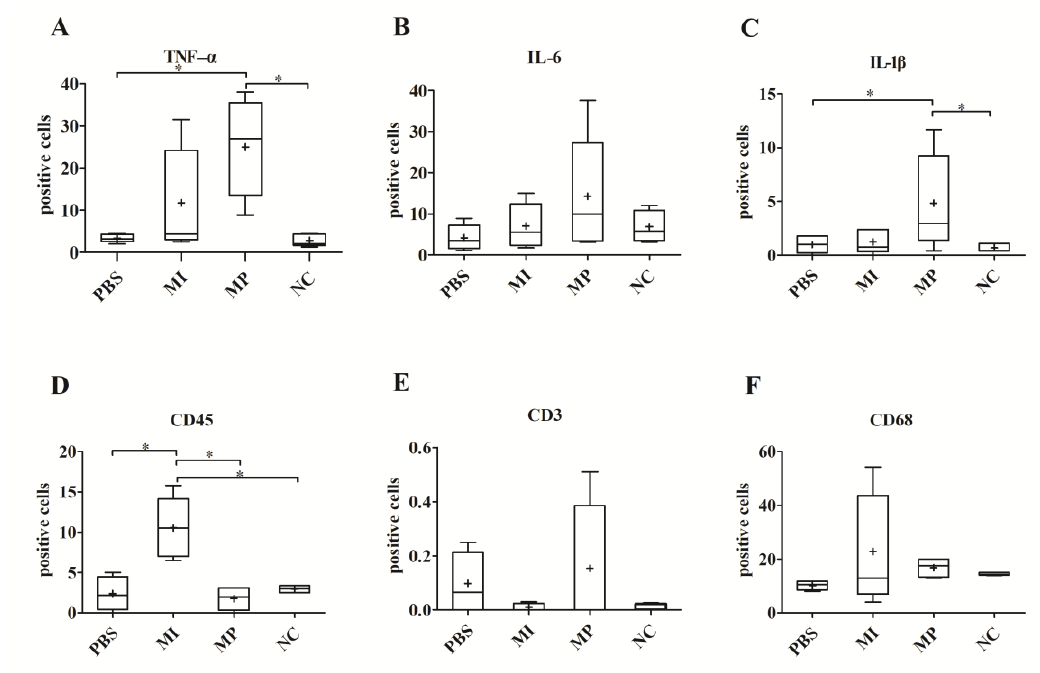
Figure 3. Expression of all biological markers in the synovial layer of right murine knees. The aim of examining the right knees was to evaluate systemic reactions caused by the dissemination of metal particles and metal ions. ( A ) The expression of TNF- α in the synovial layer of right murine knees. ( B ) The expression of IL-6 in the synovial layer of right murine knees. ( C ) The expression of IL-1 β in the synovial layer of right murine knees. ( D ) The expression of CD45 in the synovial layer of right murine knees. The MI group exhibited a significant di ff erence compared with the PBS groups ( p < 0.05). ( E ) The expression of CD3 in the synovial layer of right murine knees. ( F ) The expression of CD68 in the synovial layer of right murine knees. (* p < 0.05).